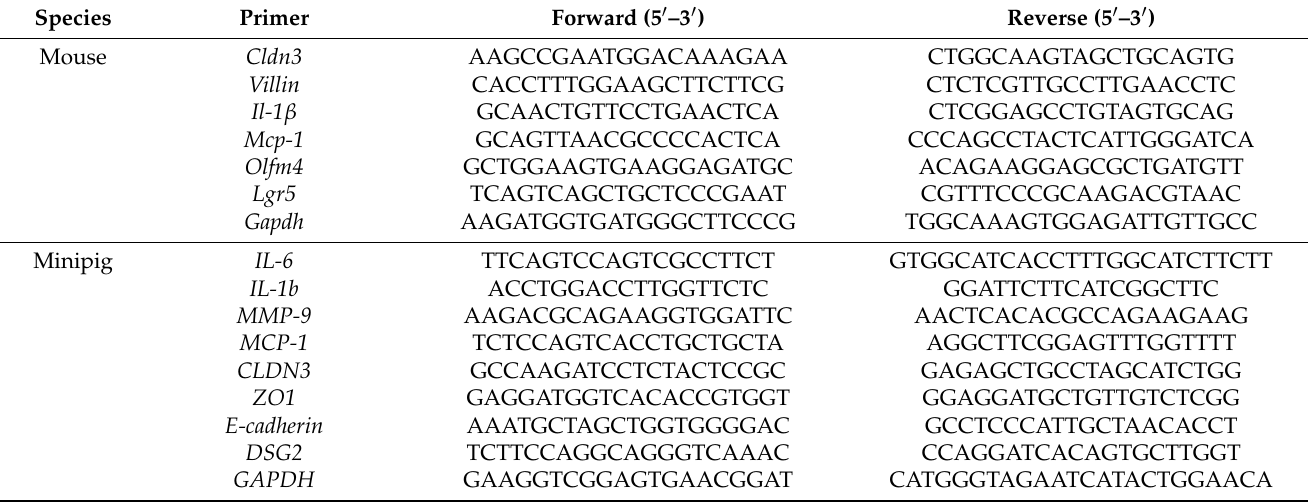
Table 1. The primer